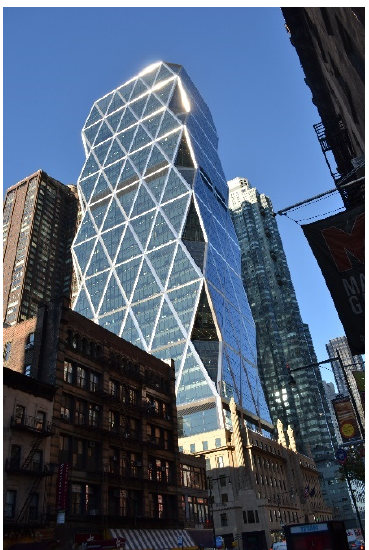
Figure 11. The Hearst Tower (2003) in New York City. (Photo by K. Al-Kodmany). Besides structural capabilities, diagrid systems offer new aesthetic expressions. These can be analyzed by examining several elements, including scale, inclination, material, form, structural details, façade design, color, and lighting systems. Indeed, diagrid struc- tures have the flexibility to be configured in varied ways; for example, the diagonals can be placed at uniform or variable angles and are suited to complex building shapes [21,22].